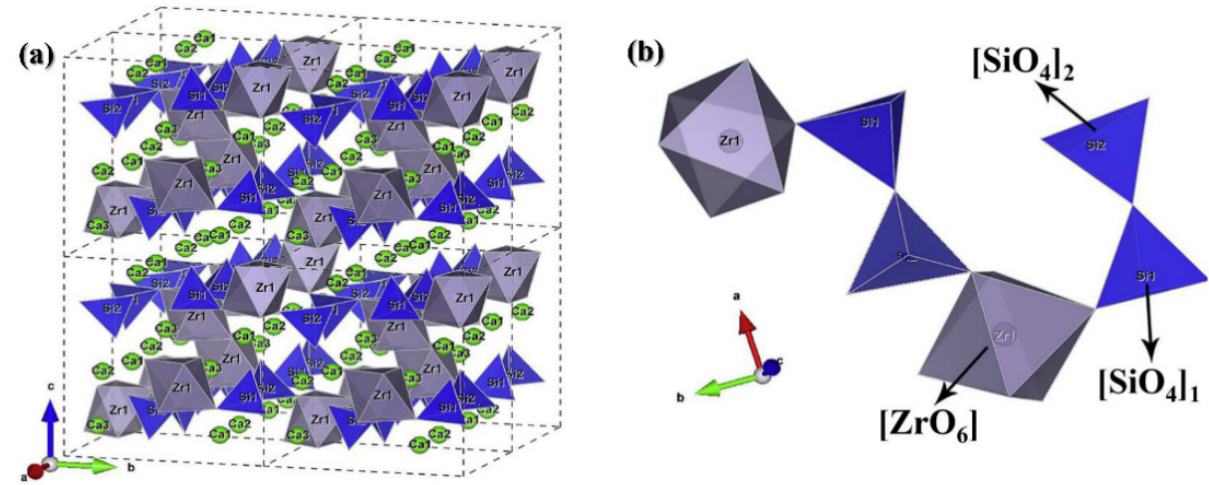
Coatings 2021 , 11 , x FOR PEER REVIEW Figure 10. Crystal packet ( a ) and magnification ( b ) structure of Ca 3 ZrSi 2 O 9 .